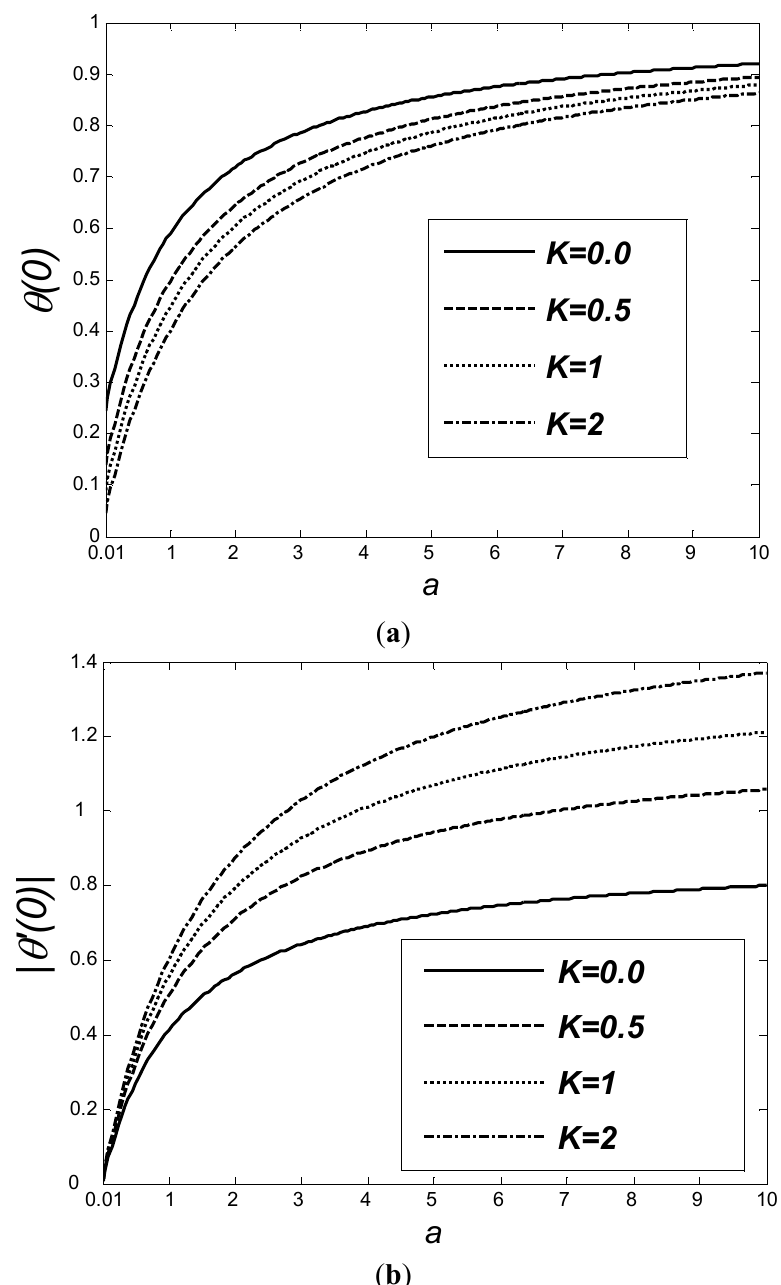
Figure 10. ( a ) Variation of the θ (0) and ( b ) | θ ' (0)| as a function of a for various values of K when M = 0.3, Pr = 7, f = 0.2 and Ec = w